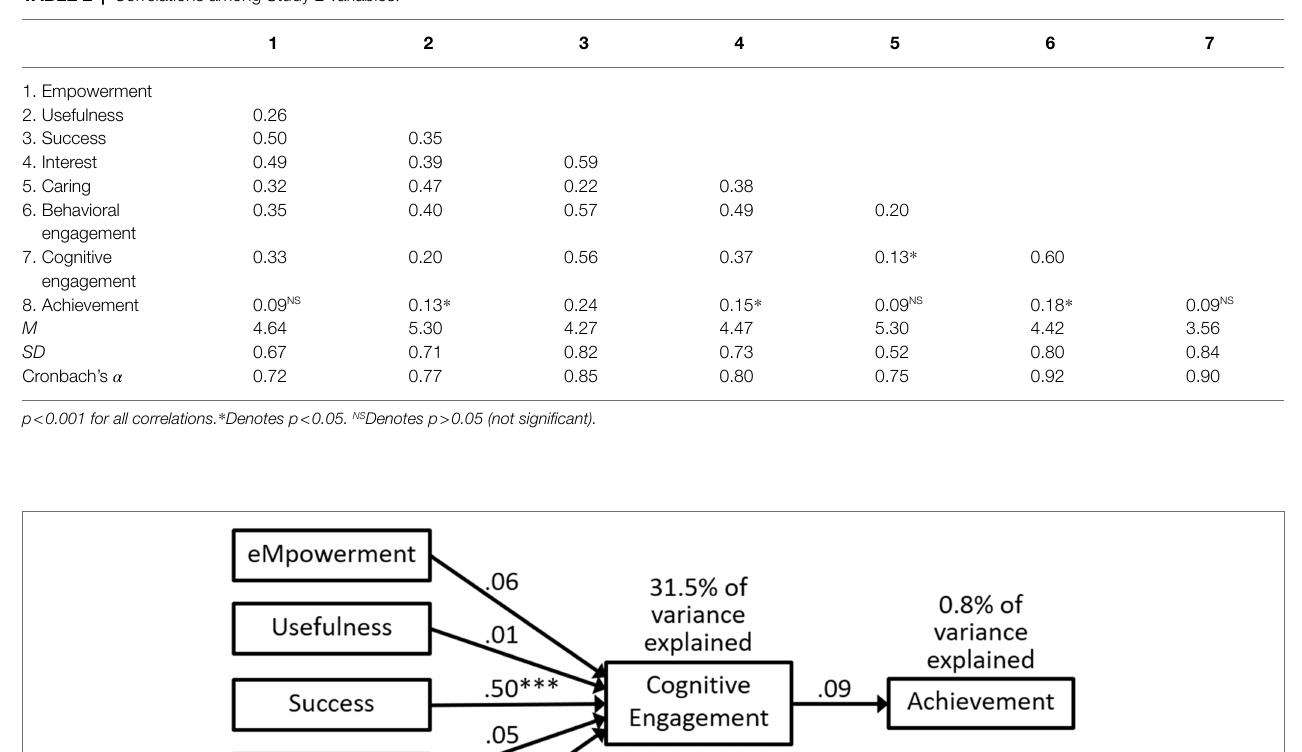
TABLE 2 | Correlations among Study 2 variables.